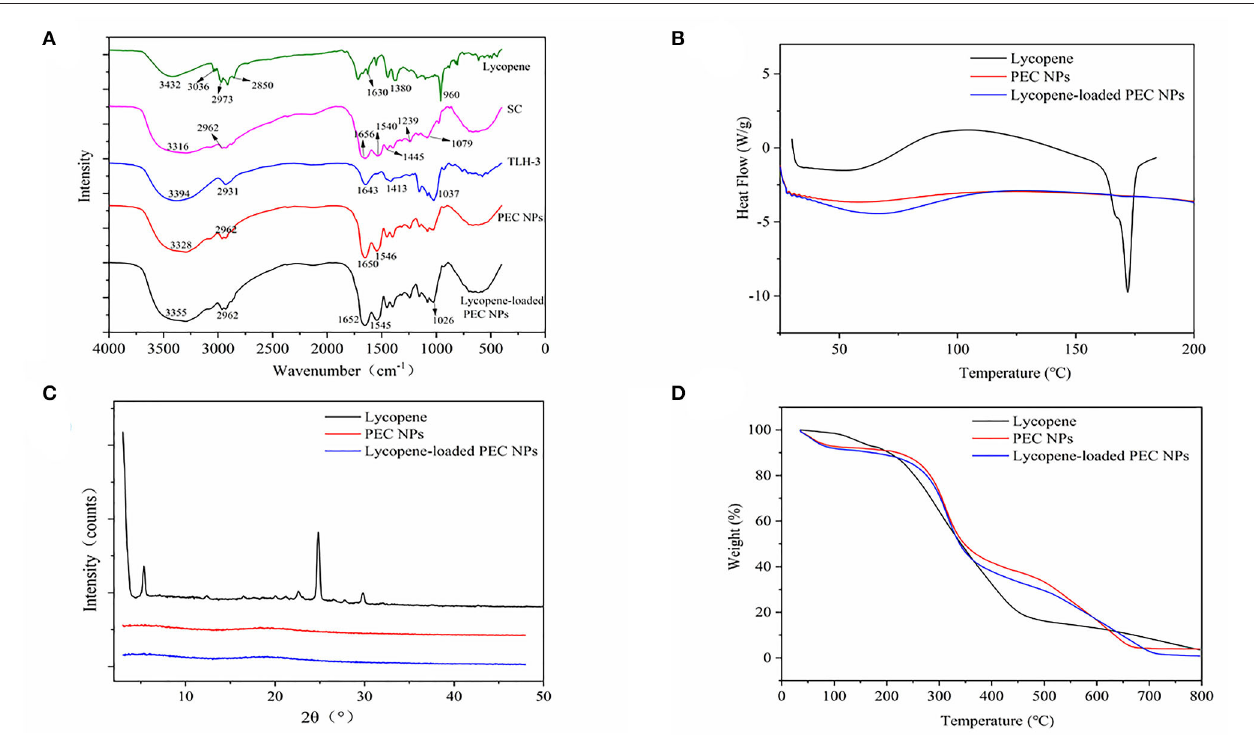
FIGURE 5 | (A) Fourier transform infrared spectroscopy spectrum. (B) The differential scanning calorimetry. (C) X-ray diffraction spectra and (D) Thermogravimetric analysis.